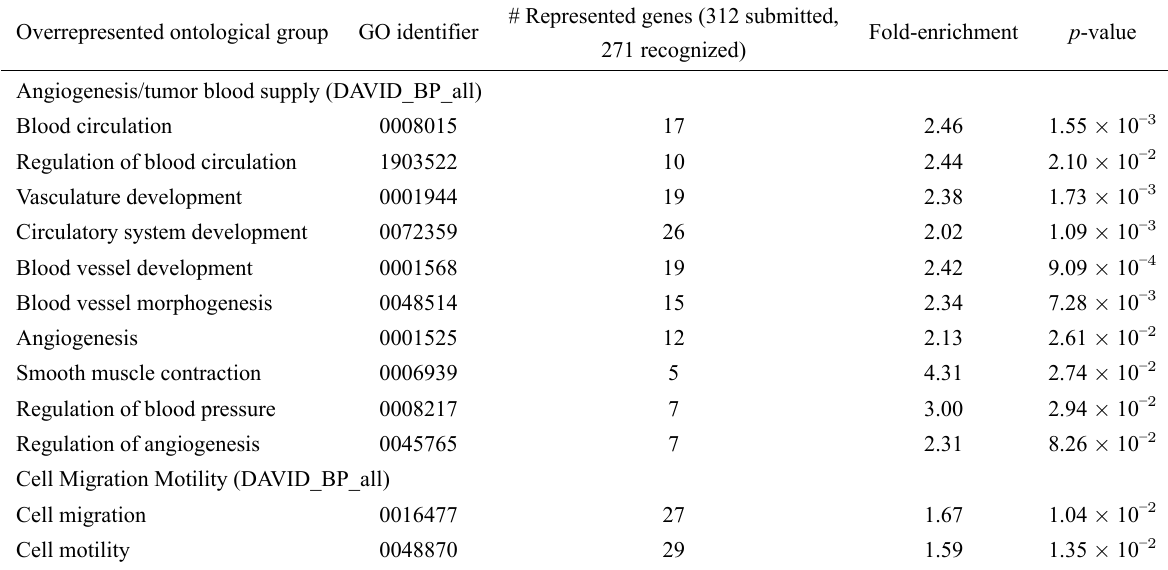
Table 2B. Gene ontology analysis of differentially expressed genes in common between PROL1 knockout or PROL1 overexpression in LNCaP cells: angiogenesis/tumor blood supply/cell migration associated. Overrepresented ontological